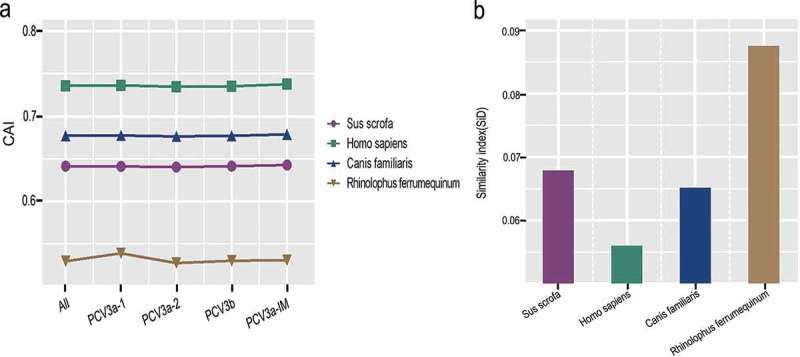
(a) CAI and (b) SiD analysis of different genotypes of PCV3 coding sequences in relation to potential host species, including Sus scrofa (purple), Homo sapiens (green), Canis familiaris (blue) and Rhinclophus ferrumequinum (brown).